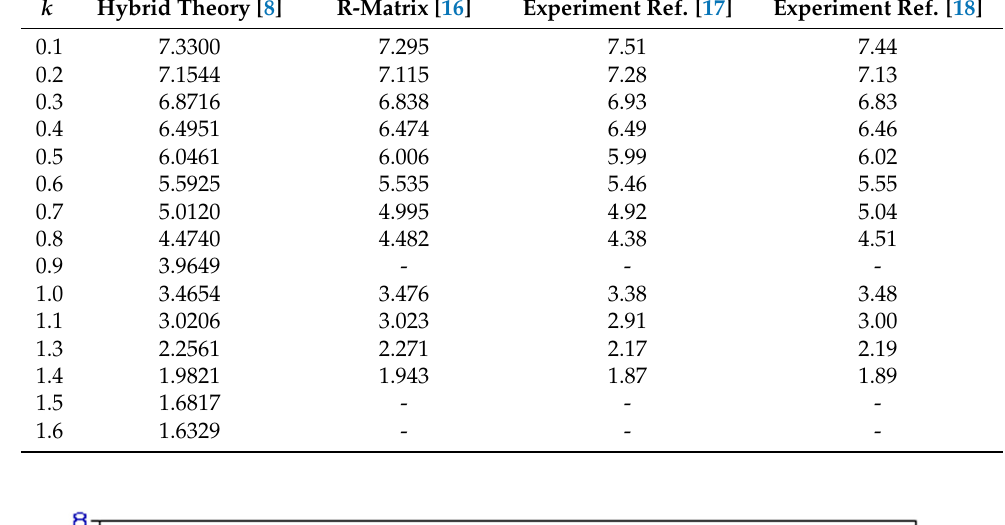
Table 2. Photoionization cross sections (Mb) for the ground state of He obtained with correlations.